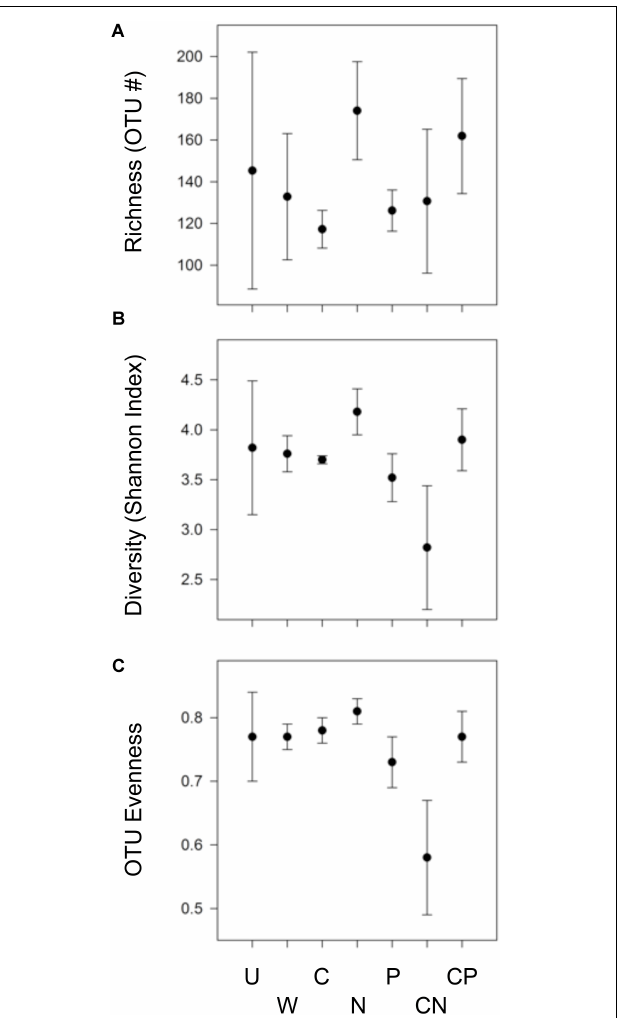
FIGURE 1 | Only the addition of CN and N altered bacterial OTU richness and (A) , diversity (B) , or evenness (C) . Treatments include: carbon as mannitol (C), nitrogen as equal concentrations NH 4 + and NO 3 - (N), phosphorus (P), C and N (CN), C and P (CP), water only (W), and an un-amended control (UN). Values are means ( n = 3) shown with accompanying 95% confidence intervals based on 16S rDNA community libraries (97% similarity cut-off).